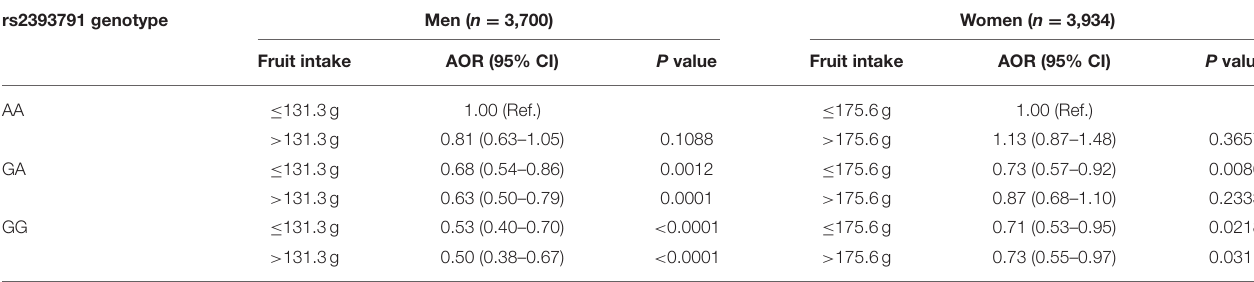
TABLE 4 | Association of HNF1A rs23939791 genotype and fruit intake with inflammation. rs2393791 genotype